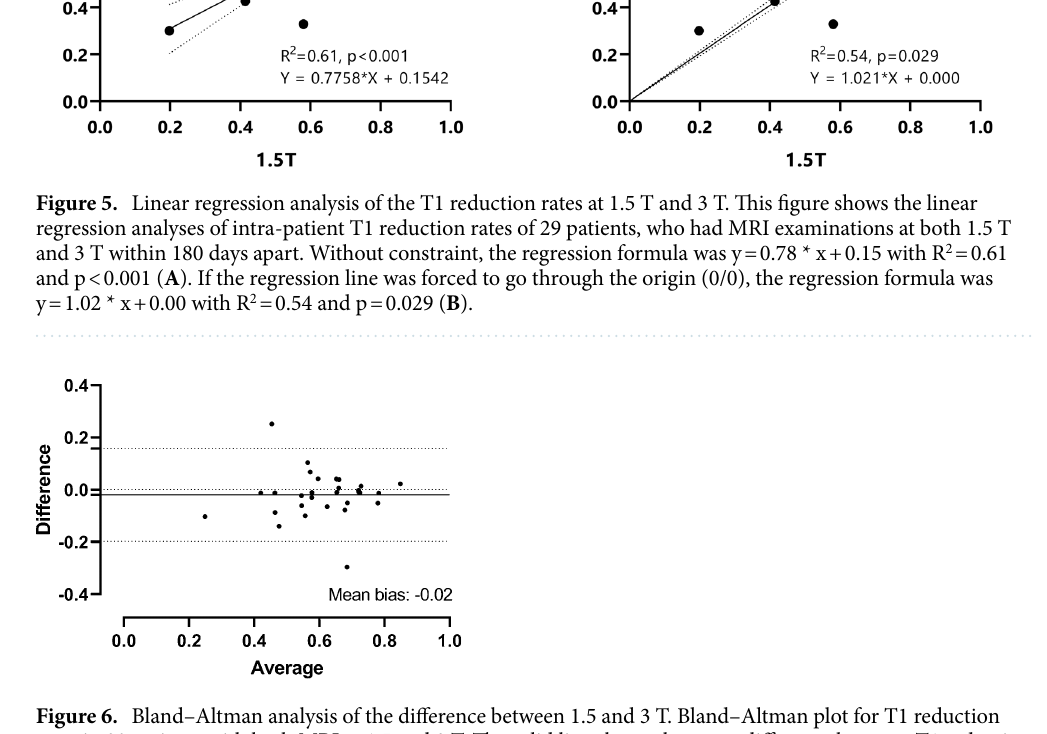
Figure 6. Bland–Altman analysis of the difference between 1.5 and 3 T. Bland–Altman plot for T1 reduction rates in 29 patients with both MRI at 1.5 and 3 T. The solid line shows the mean difference between T1 reduction rates at 1.5 T and 3 T. The mean bias to the zero line was − 0.02. The upper and lower dotted lines indicate the upper and lower 95% limit of